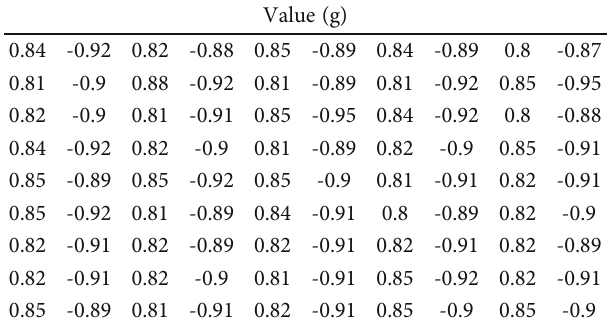
Table 2: Repeatability test data of acceleration recorder ( z -axis, unit: